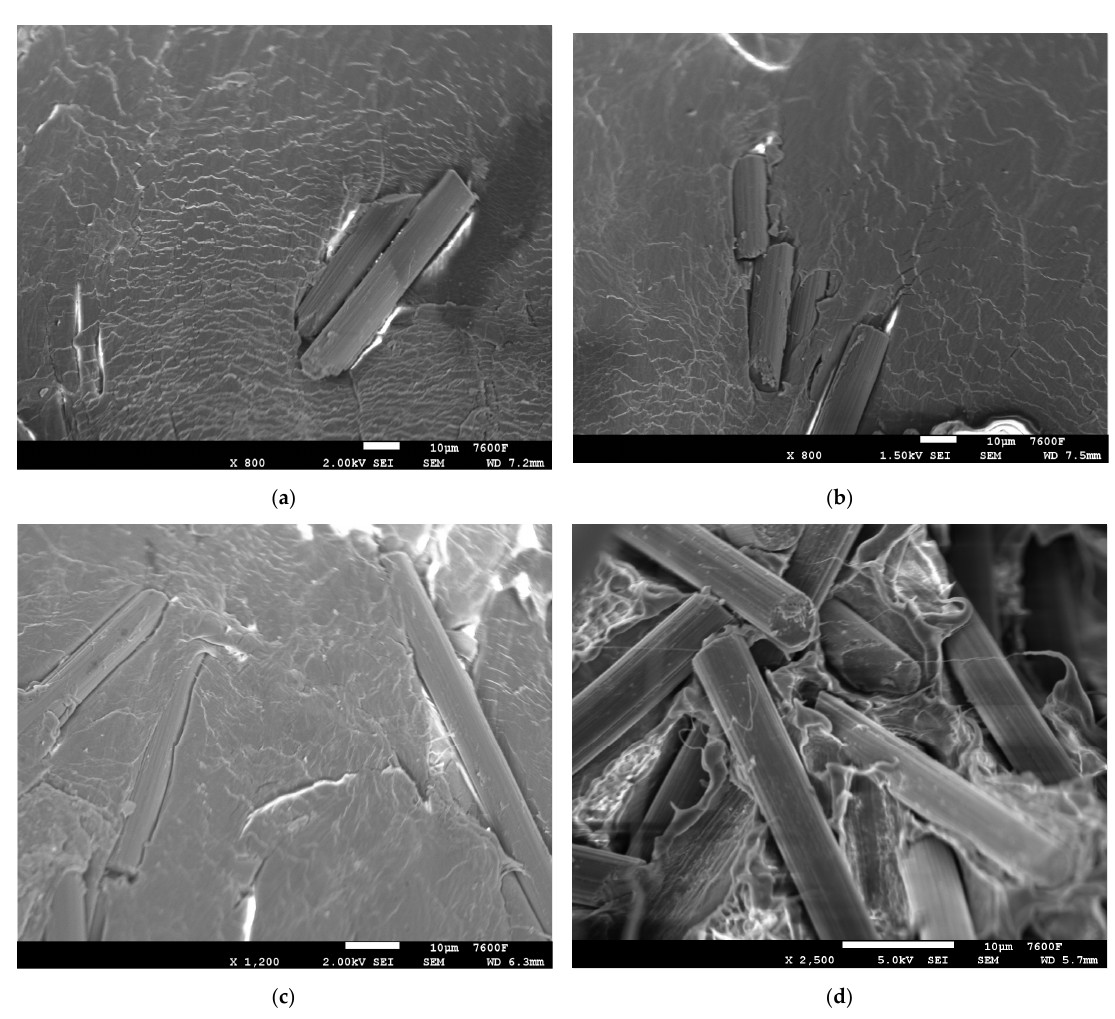
Figure 6. SEM images: ( a , b ) 5% CF/PE, ( c ) 10% CF/PE and ( d ) 15% CF/PE combinations.